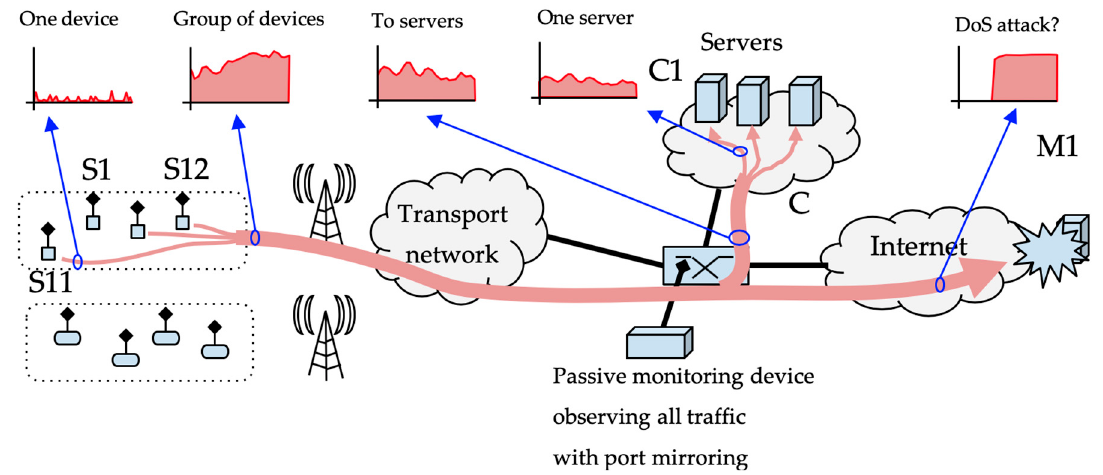
Figure 2. Network scenario with devices grouped by network address.